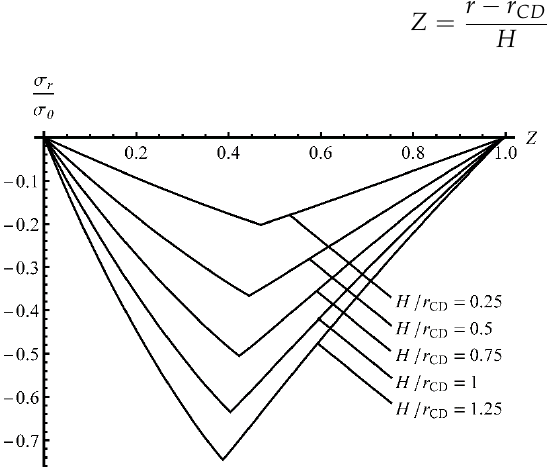
Figure 2. Through ‐ thickness distribution of the radial stress at γ = 0.1 and several process stages. Figure 2. Through-thickness distribution of the radial stress at γ = 0.1 and several process Figure 6 demonstrates the effect of  on the dimensionless bending moment. The broken line corresponds to the rate ‐ independent material model (i.e., the material obeys Swift’s strain ‐ hardening law). The bending moment increases as  increases, which is in agreement with physical expectations. The increase in the bending moment is sharper for smaller values of  . It is worthy of note that the bending moment is nearly constant for a given value of  . Figure 3. Through ‐ thickness distribution of the circumferential stress at γ = 0.1 and several process stages.